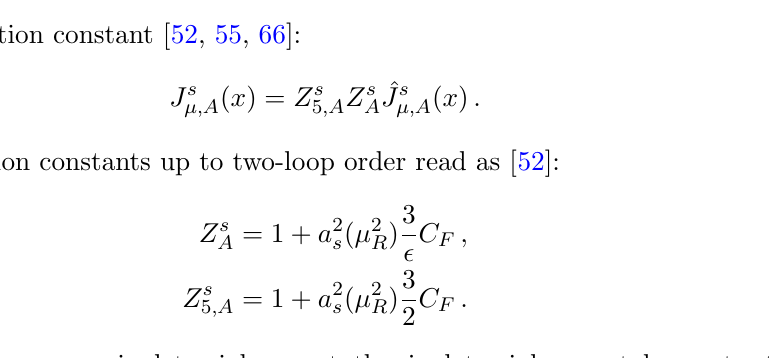
Figure 4 . Singlet Feynman diagrams at two-loop